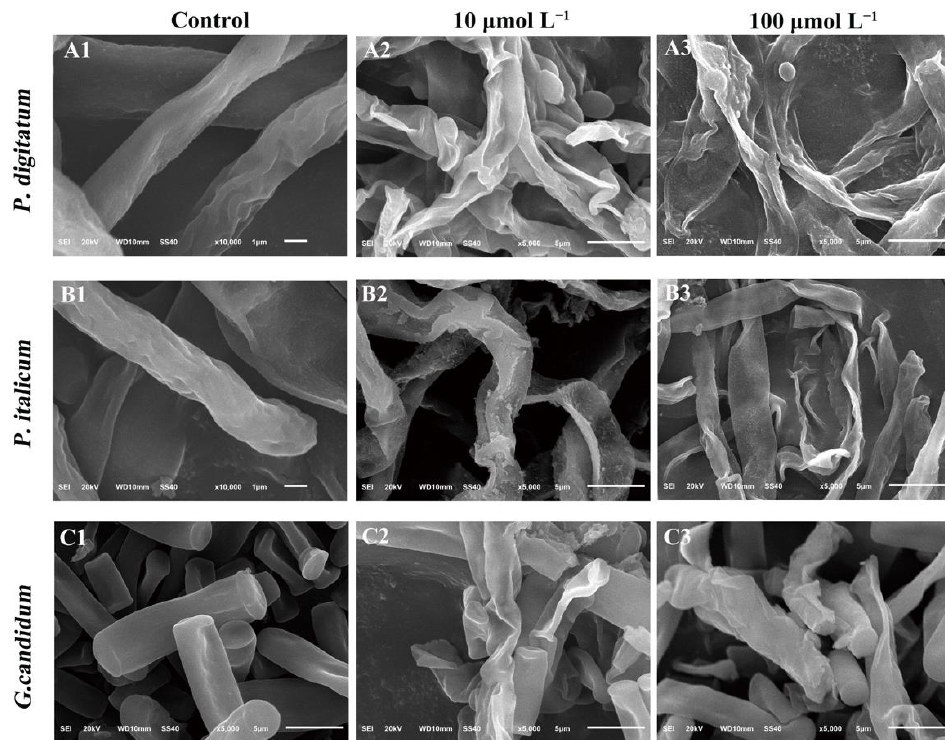
Figure 2. SEM images of P. digitatum (panels A ) , P. italicum (panels B ), and G. candidum (panels C ) mycelia treated with PAF56. Mycelia were incubated in 5% PDB without PAF56 ( A1 – C1 ) or with PAF56 at final concentrations of 10 μmol L −1 ( A2 – C2 ) or 100 μmol L −1 ( A3 – C3 ).